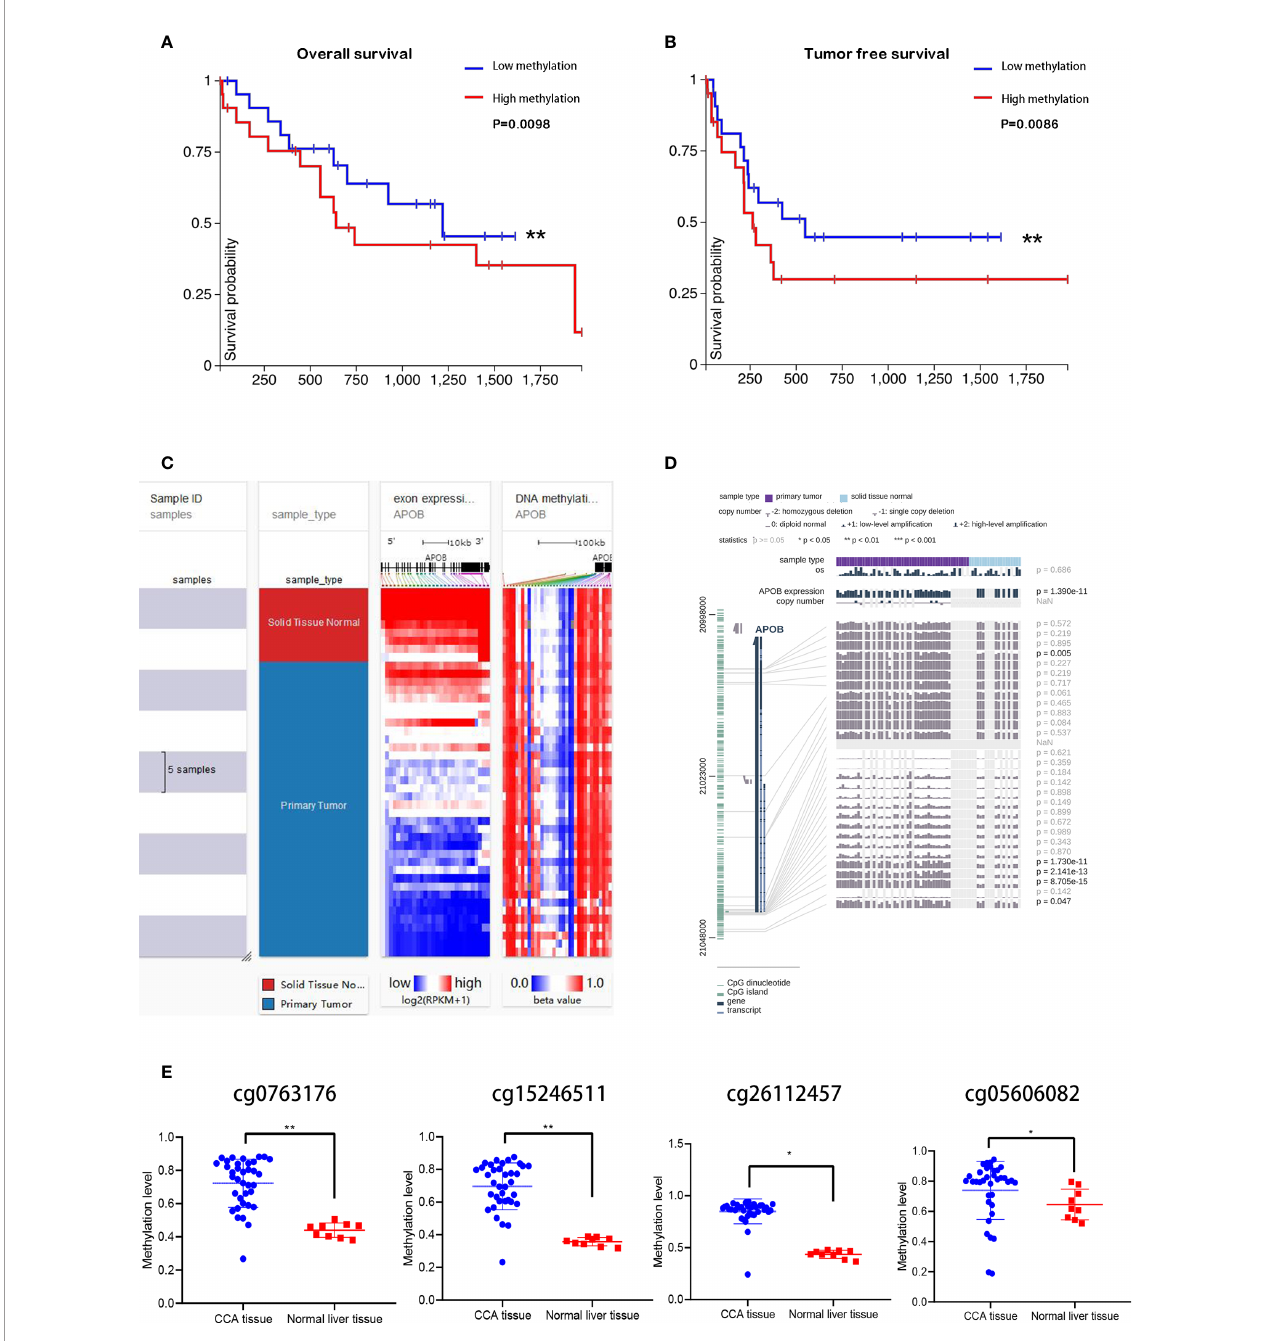
FIGURE 7 | The APOB expression was correlated to DNA methylation in CCA. Through Kaplan-Meier analysis, the high APOB DNA methylation group showed worse prognosis than low APOB DNA methylation group in CCA (A, B) . Taking the application of the UCSC Xena database, we observed that normal liver tissues showed higher APOB expressions than CCA tissues, and the DNA methylation level was negatively correlated with the APOB expression in CCA (C) . Additionally, with the help of MEXPRESS, it can be noted that the tumor tissues showed higher methylation levels when compared with the normal liver tissues in the APOB CpG islands — cg0763176, cg15246511, cg26112457, and cg05606082, these four sites are the target sites of the APOB CpG island (D, E) . *P < 0.05, **P <